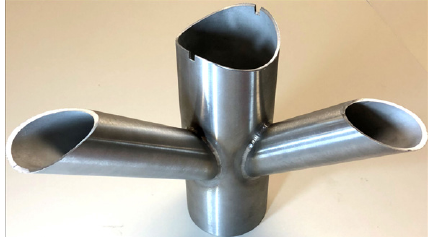
Figure 12: AWJ-machined “fish mouth” weld joints on stainless